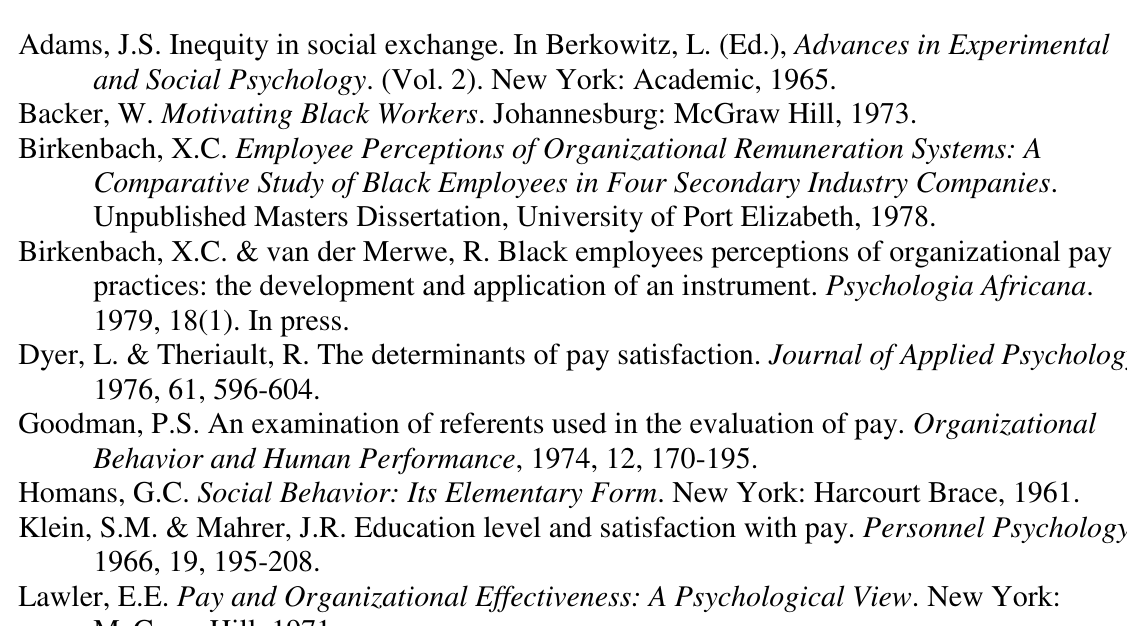
Black workers’ satisfaction with their pay (X.C. Birkenbach and R. van der